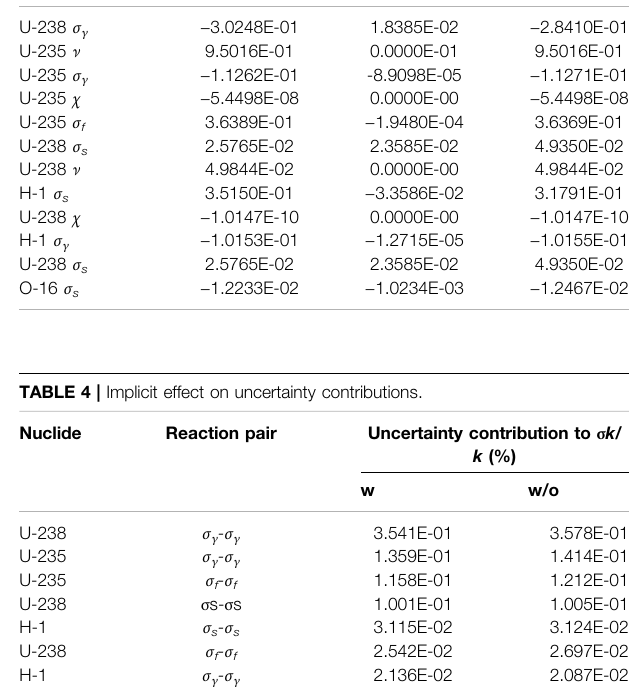
TABLE 3 | Sensitivity coef fi cients of k eff with respect to some. Representative reaction types of cross section. Reaction type